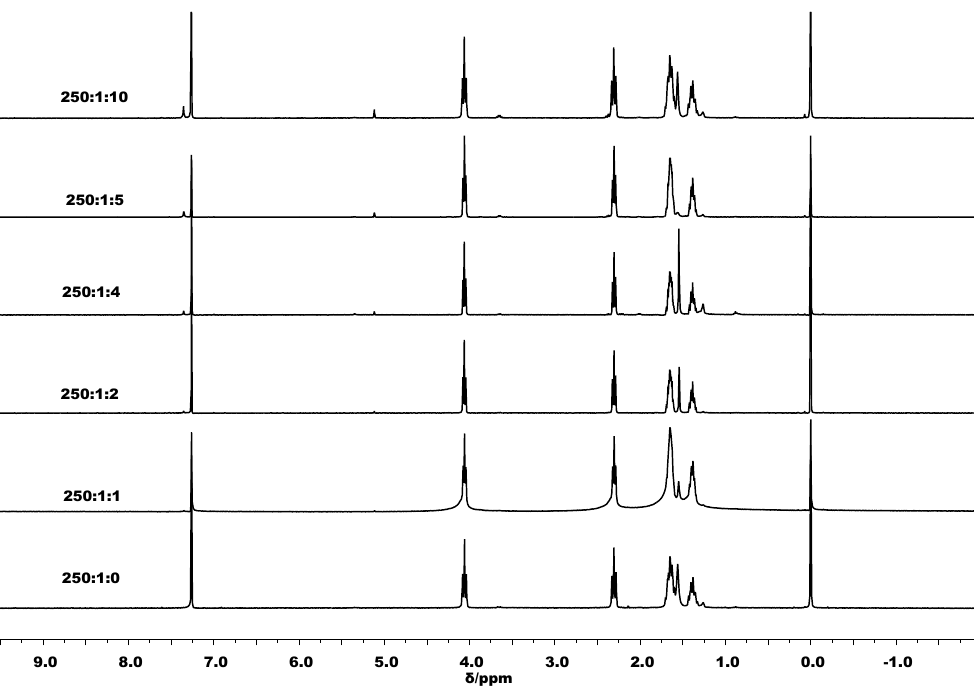
Figure 5. The 1 H NMR spectra of the PCL obtained using C1 with different amounts of BnOH (runs 5, 13–17, Table 4).